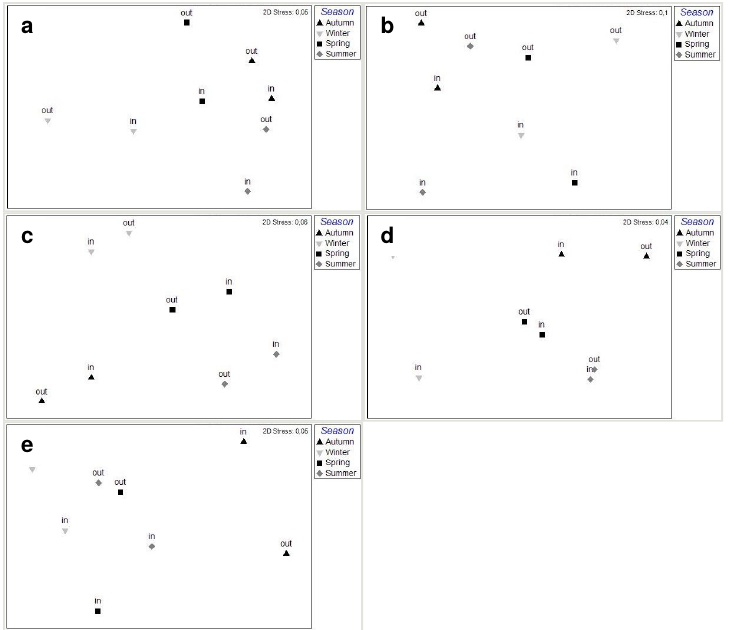
Figure 6. nMDS analysis plots between the stations based on the abiotic data of four sampling